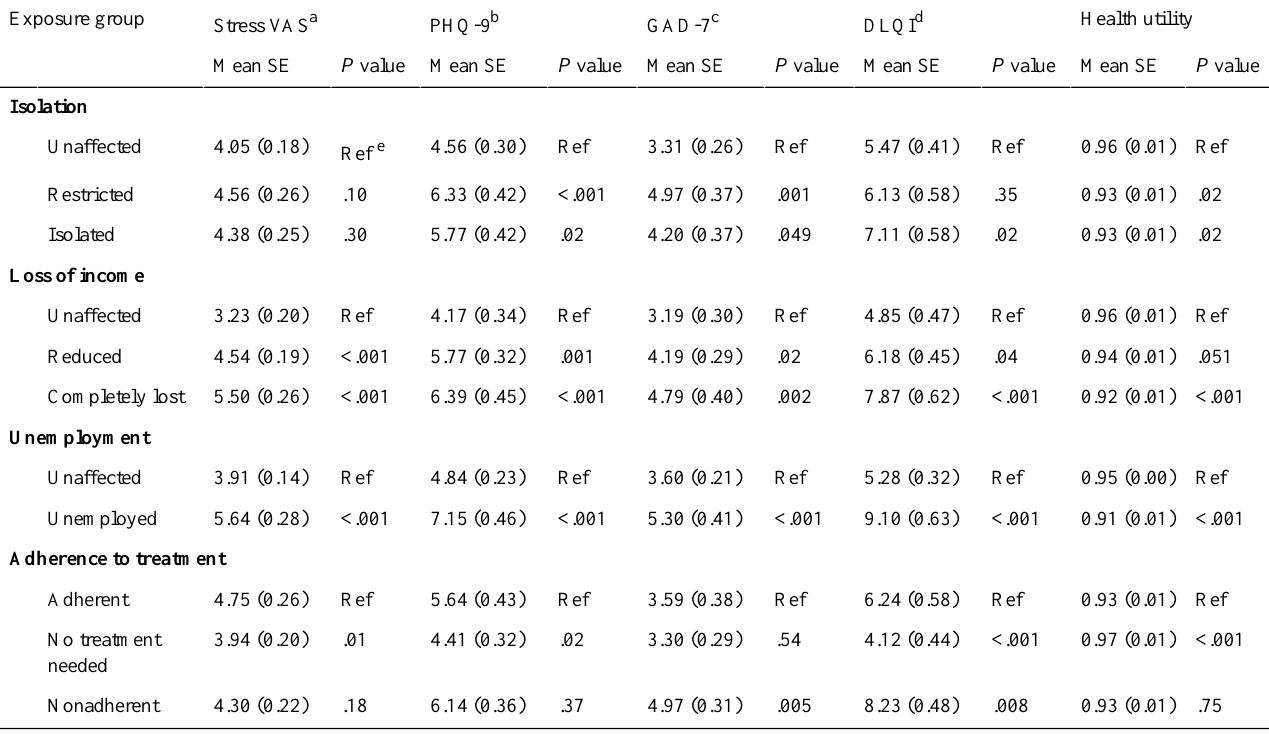
Table 2. Associations of epidemic-related impacts with patient-reported outcome scores of skin diseases